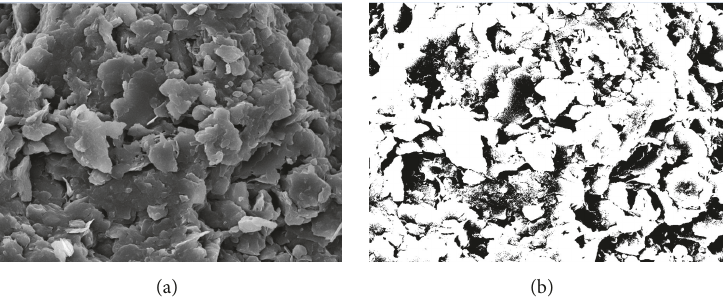
Figure 13: Local micrograph of the mudded weak interlayer (a) and the processed micrograph, based on the thresholding method